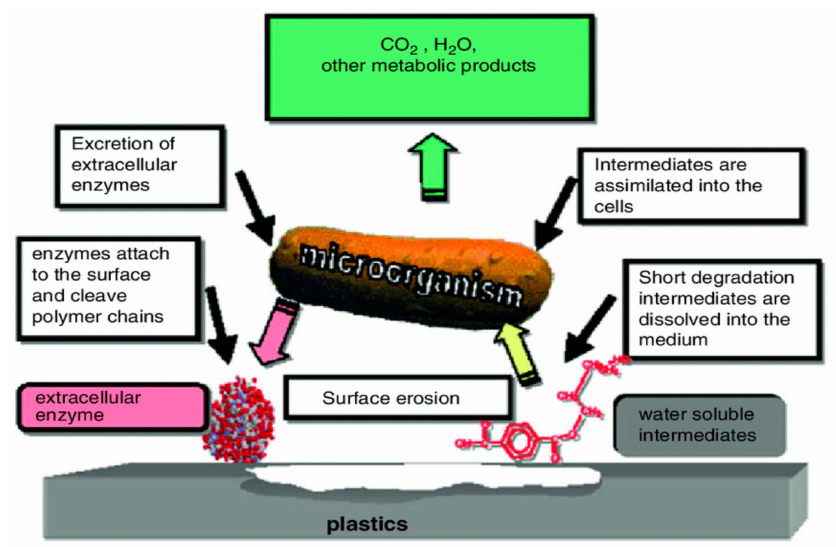
Figure 3. General mechanism of plastic biodegradation under aerobic conditions, adopted from [88] with permission from Elsevier through copyright clearance center.